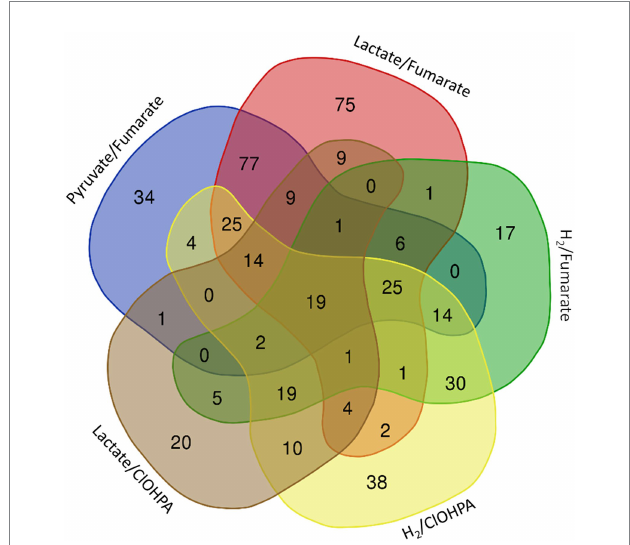
FIGURE 1 Venn diagram representing the number and distribution of 463 proteins identified as significantly up-regulated in fermentative growth conditions (Py-only) in comparison to any of the respiratory metabolisms (see also Supplementary Table 4). The 19 proteins at the centre of the diagram are listed in Table